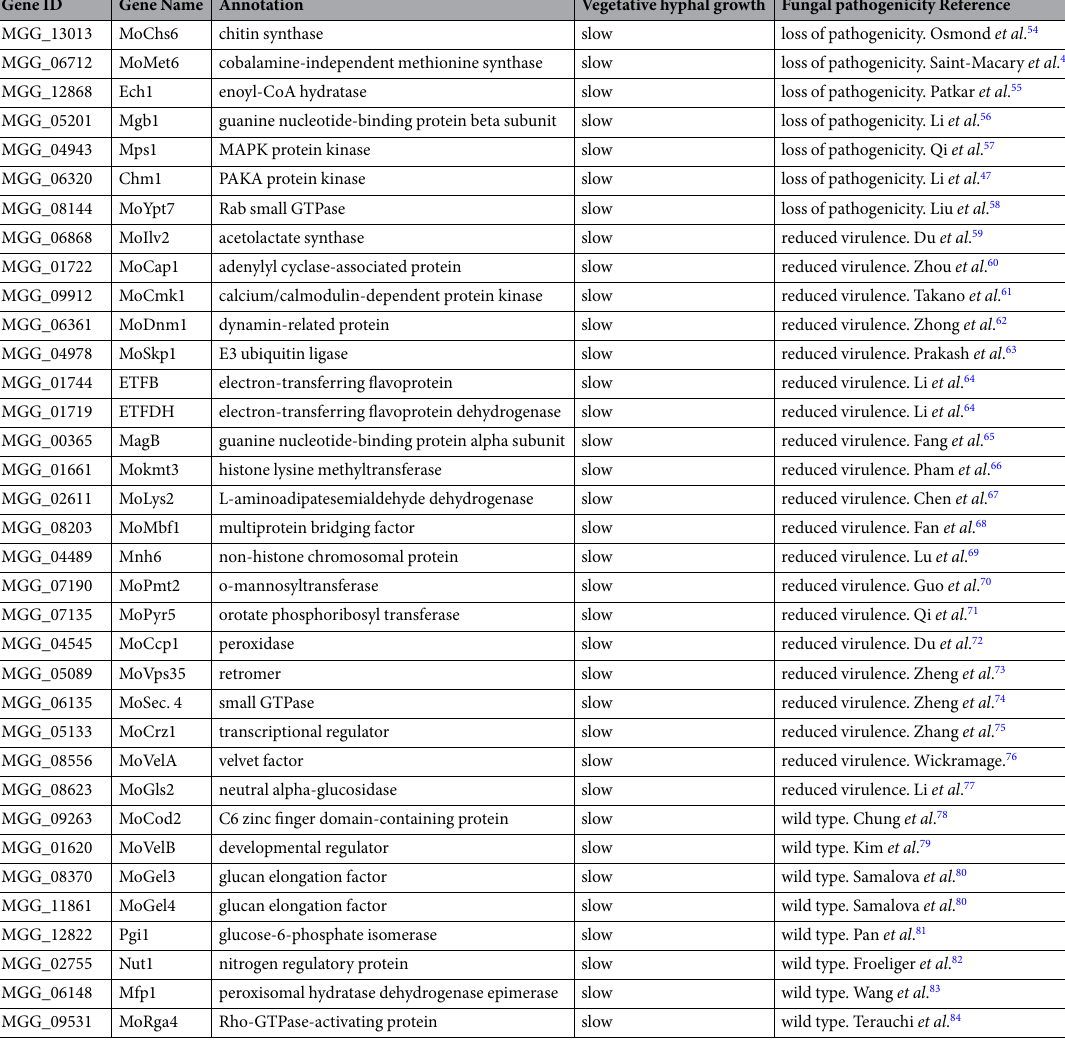
Table 1. List of acetylated proteins involved in vegetative hyphal growth and fungal